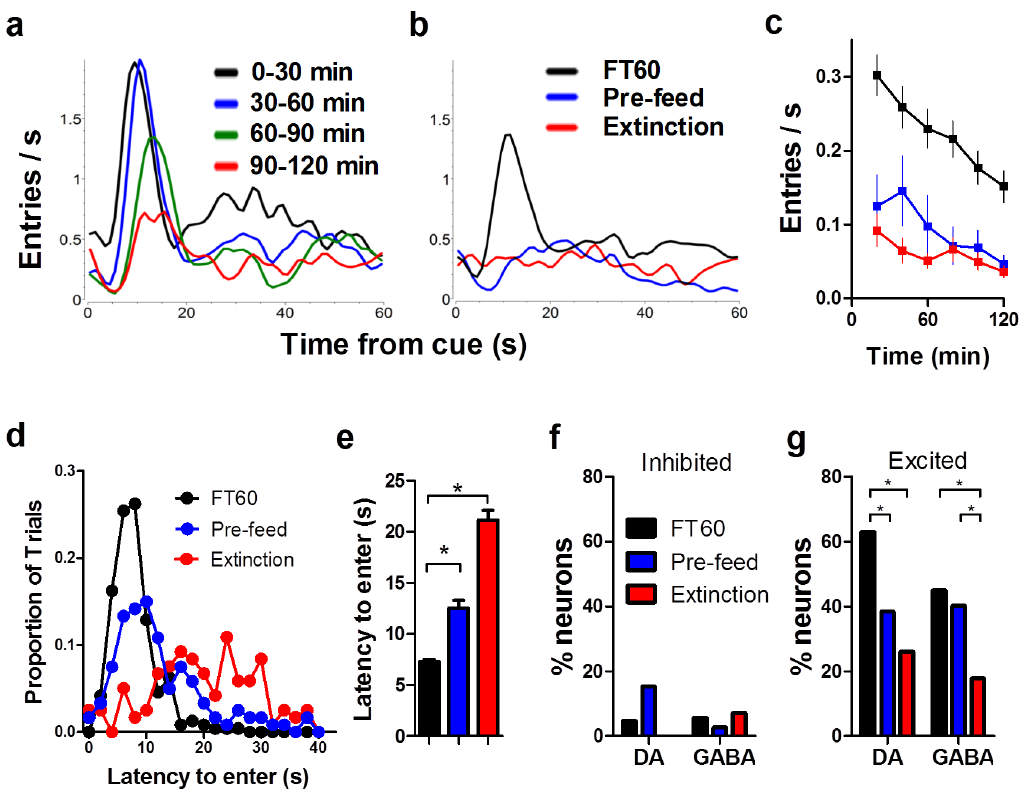
Figure 8. Food-seeking behavior gradually decreases with satiety. ( a ) Following reward delivery, mice entered the food cup to collect the pellet. Representative data from one mouse are shown. ( b ) The rapid increase in food cup entries after the reward cue was eliminated during extinction and following pre-feeding. Traces are from the same mouse. FT60 data is the average from all four blocks in a . ( c ) Rate of entries decreased as mice became sated during FT60 sessions. It was also reduced during extinction and following pre-feeding (average of all mice on all testing days; 20 min bins). ( d ) The latency to enter the food cup following reward delivery increased during extinction and following pre-feeding treatment. ( e ) Latency to enter the food cup for all mice on all testing days was pooled to yield population averages. ( f ) The proportion of DA and GABA neurons that exhibited significant inhibitions following the reward cue was unaffected by pre-feeding and extinction. ( g ) The number of excitatory responses varied as a function of motivational state for both DA and GABA neurons. * represents significant difference at alpha of